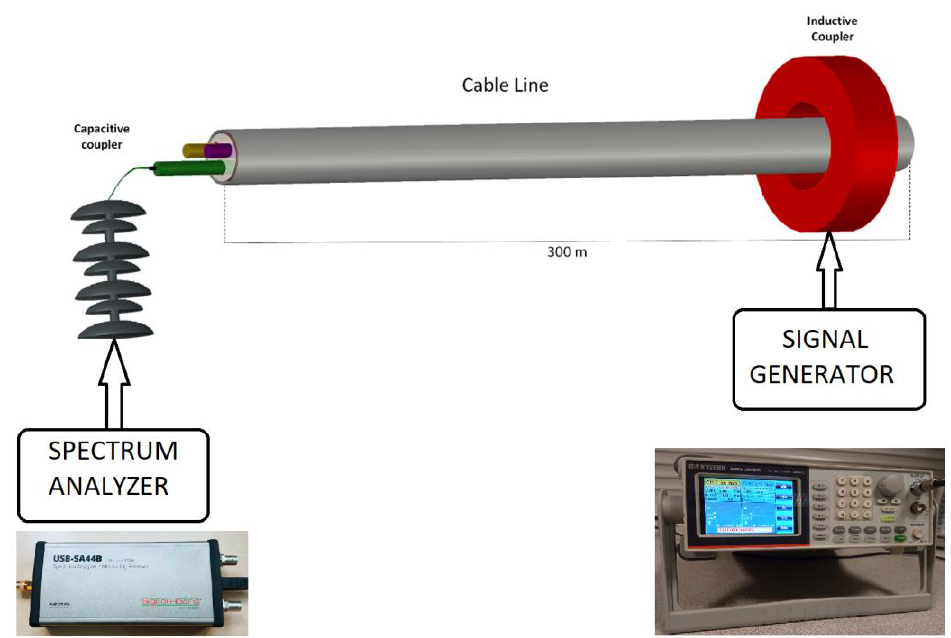
Figure 6. Methodology of performing verification measurements for mixed (capacitive – inductive) coupling.